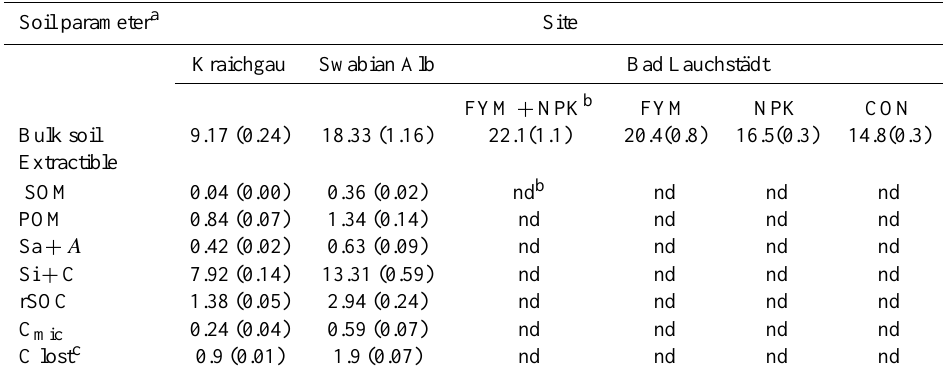
Soil parameter a